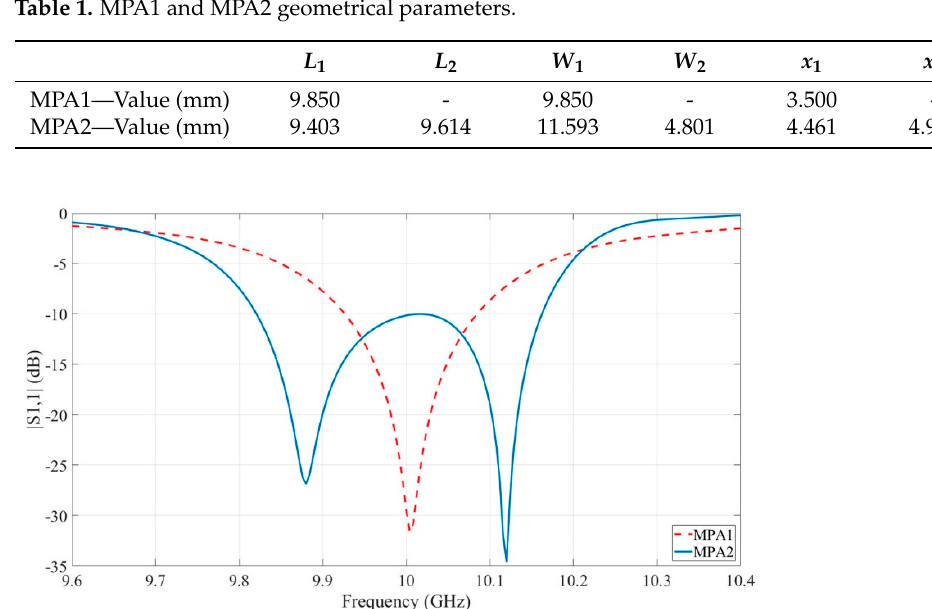
Table 1. MPA1 and MPA2 geometrical parameters.